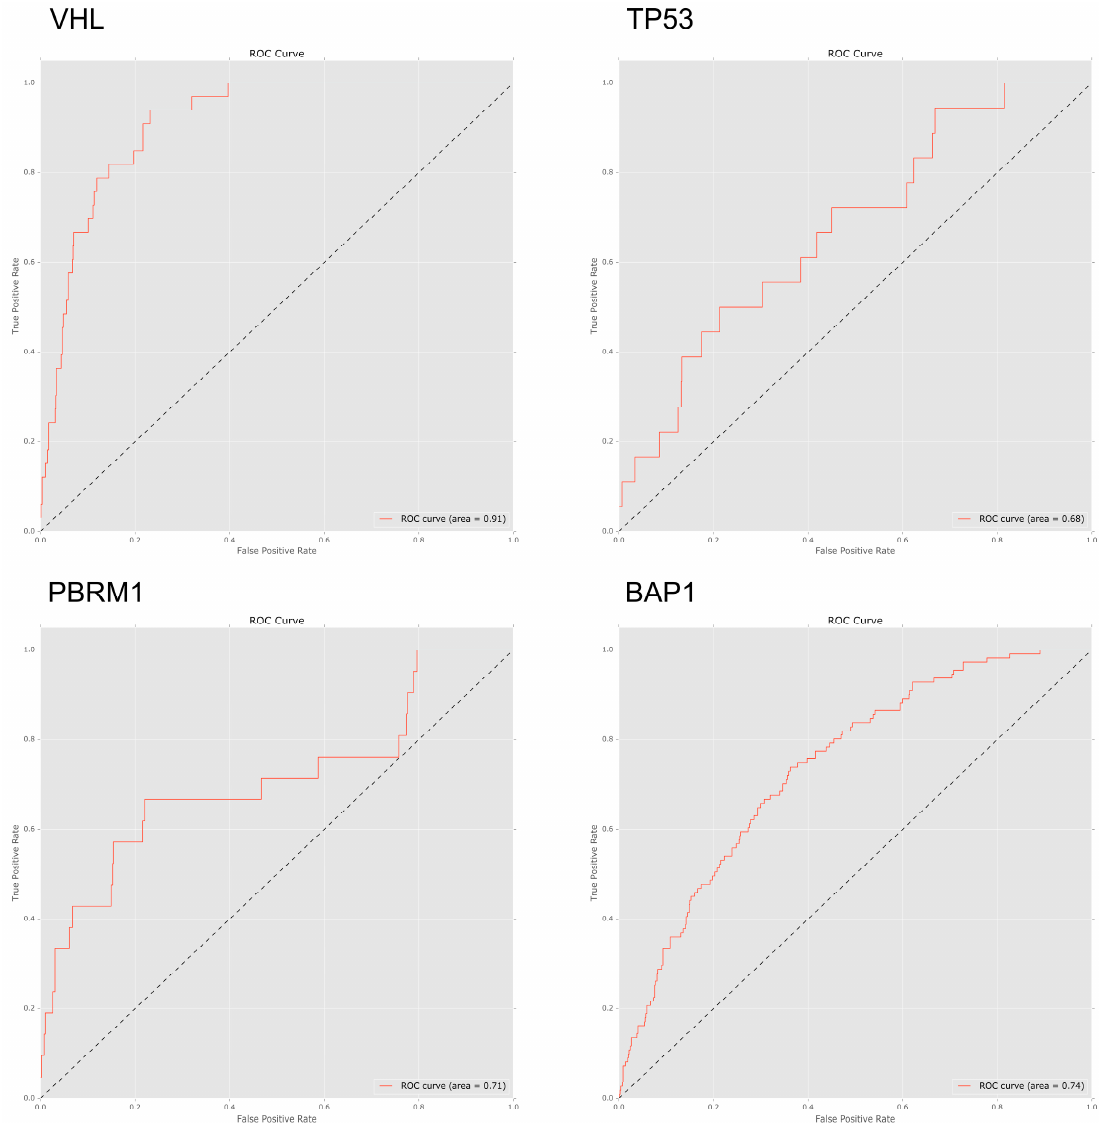
Figure 5. AUC ROC curves used to measure the performance of random forest classifiers trained on arm-wise chromosome copy number patterns to predict gene mutation status of VHL , TP53 , PBRM1 and BAP1 . A larger area under the ROC indicates better